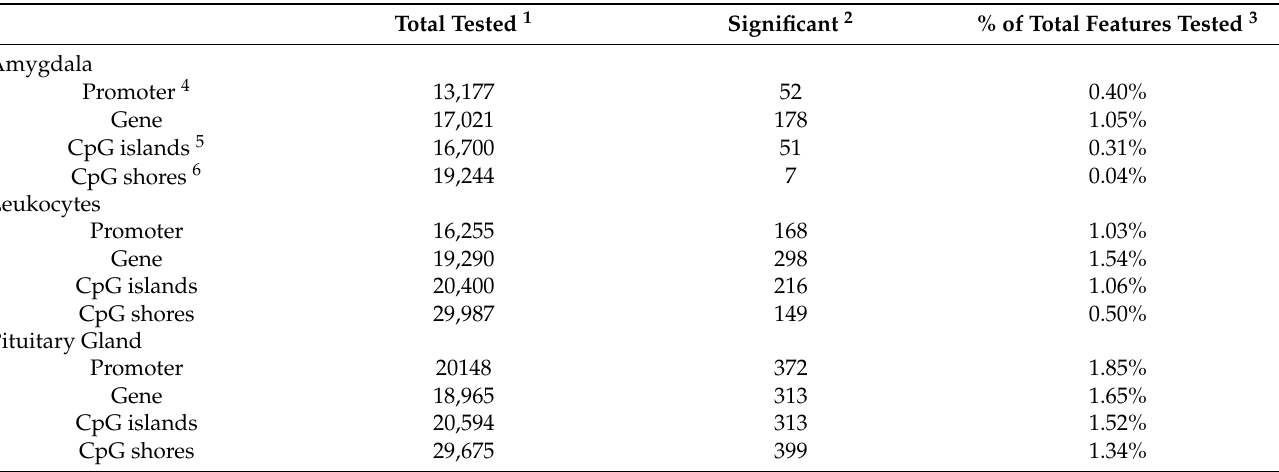
Table 3. The number of genomic features with high variability in DNA methylation between cows in the Prenatally Stressed group.